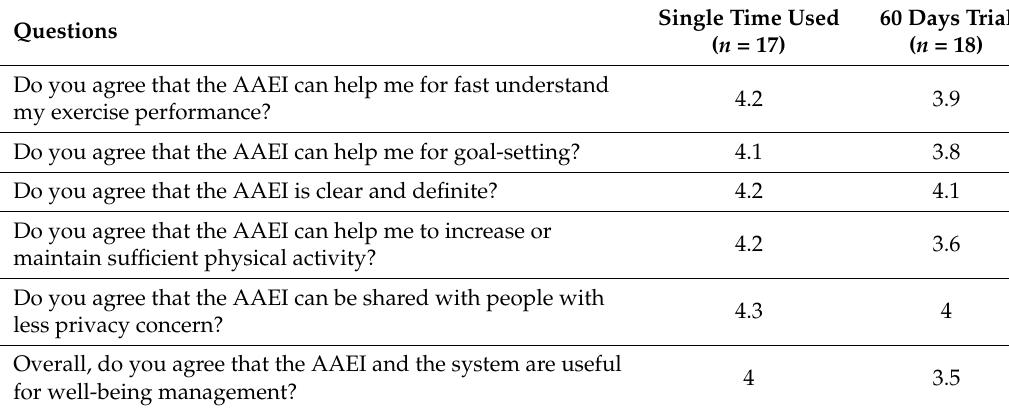
Table 3. User experience of the exercise performance measurement system. User experience of